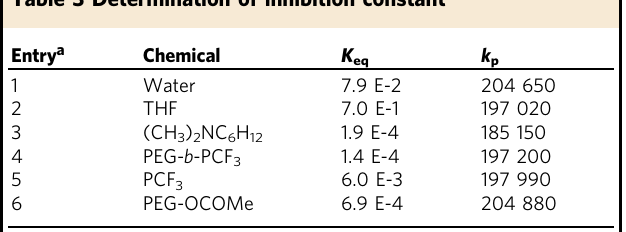
Table 3 Determination of inhibition